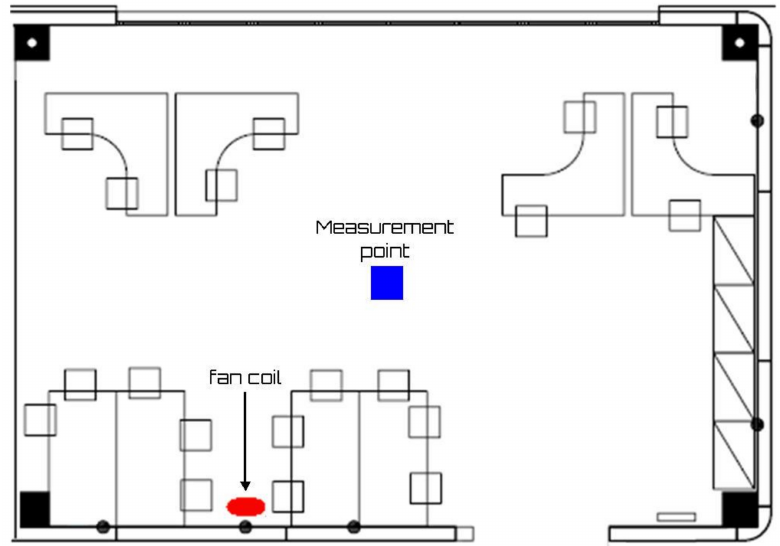
Figure 2. Open-plan office map . Four groups of stations are clearly distinguishable; the position of the HVAC and the measurement point is also indicated. The office was 7.4 m wide, 11.0 m long, and 4.0 m high. The furnishing accessories are almost all reflective, except for the curtains near the window, which are of absorbent